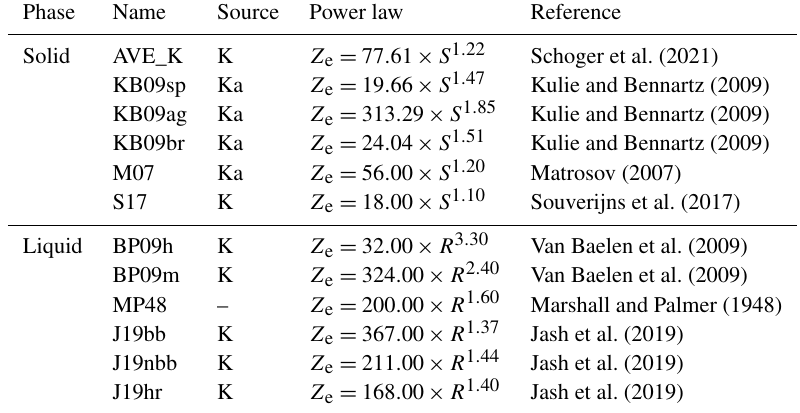
Table 2. Details for each multi-phase precipitation power law relationship.